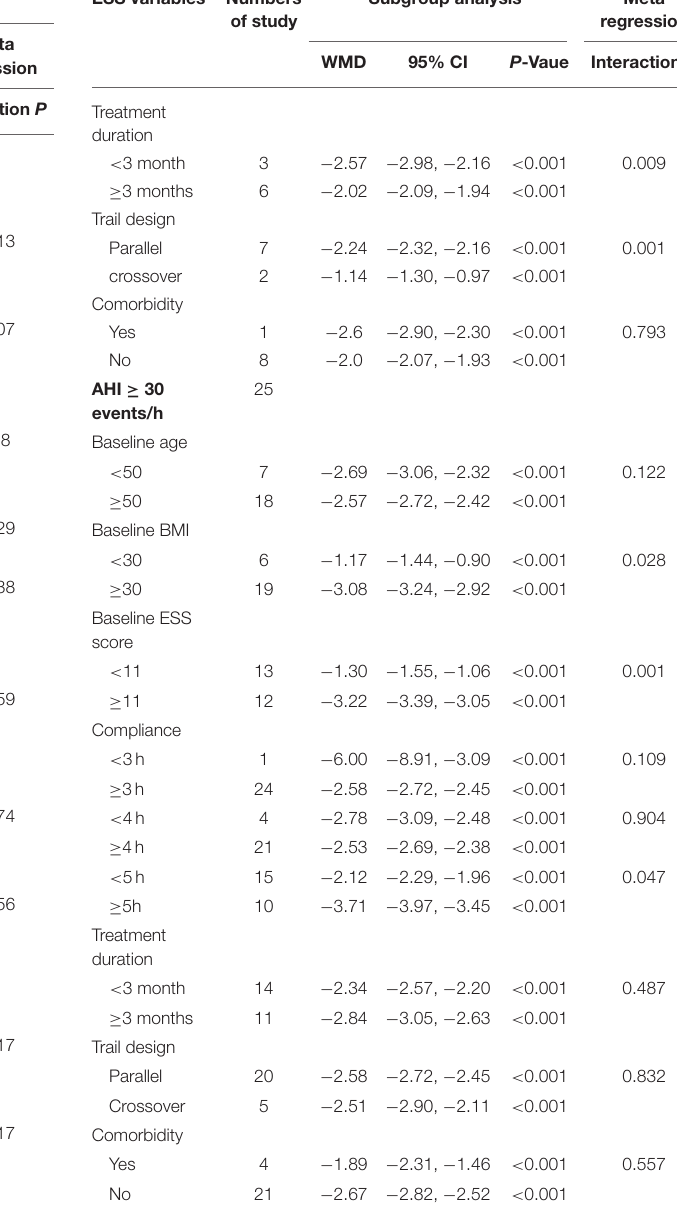
TABLE 2 | Meta-regression and subgroup analysis for subjective excessive daytime sleepiness (EDS) based on Basic characteristics of patients and studies in different severity of